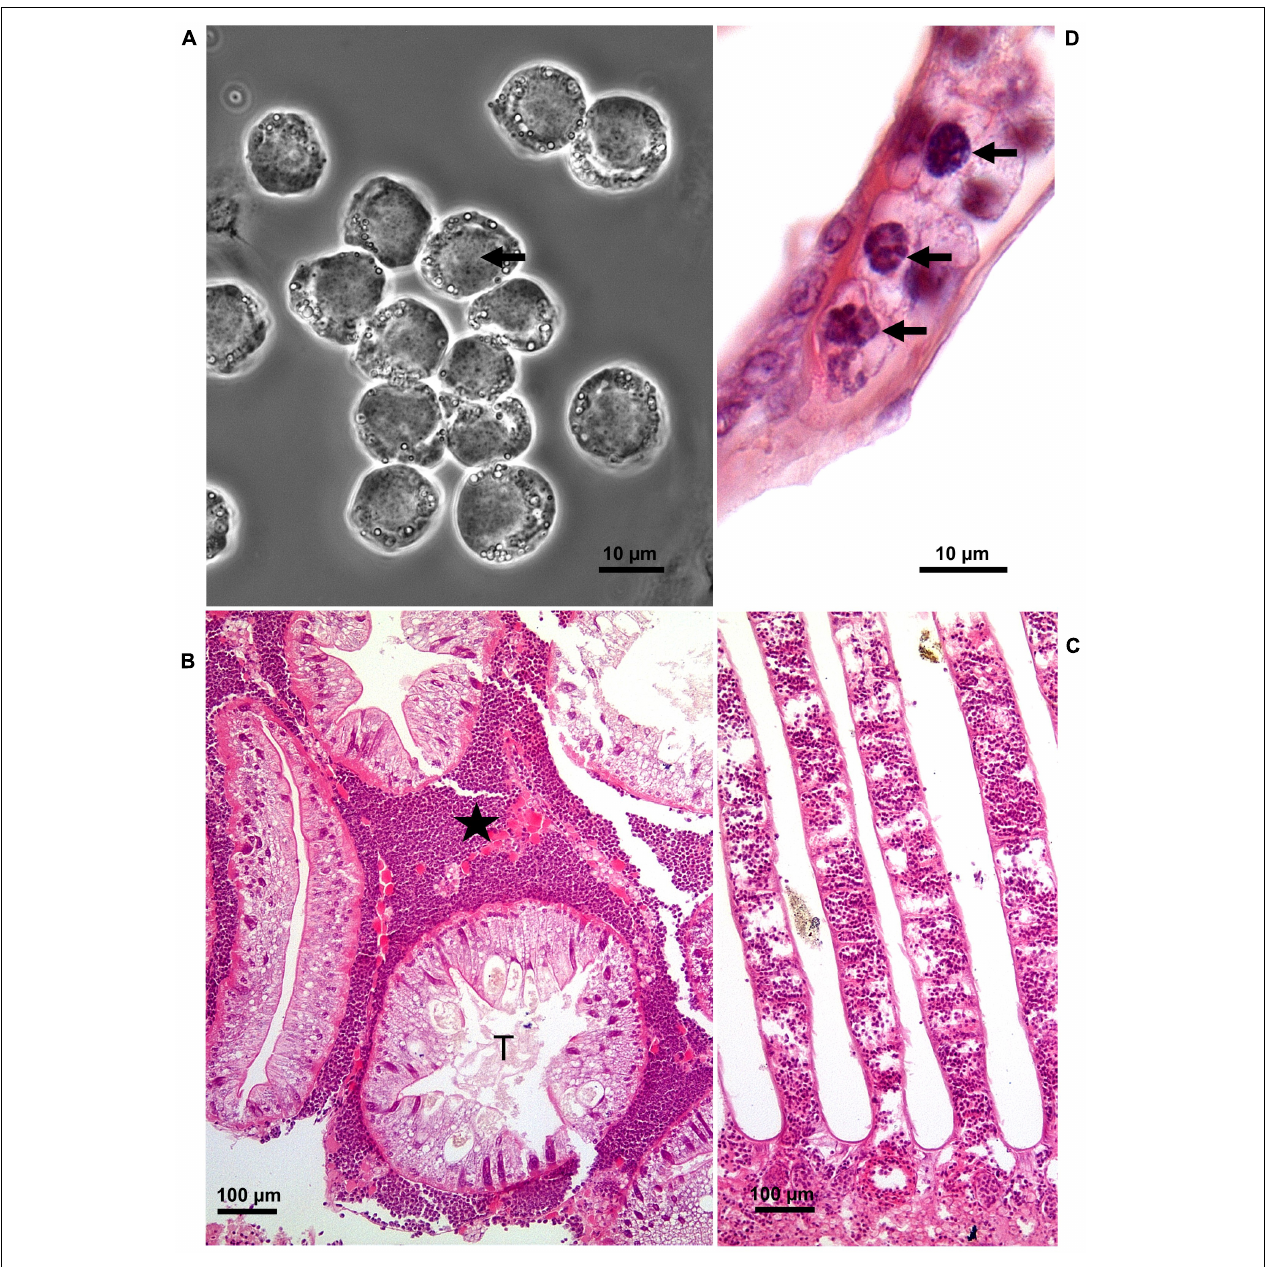
FIGURE 1 | Hematodinium infection of shore crab, Carcinus maenas . (A) Phase contrast micrograph of haemolymph replete with trophont stages of Hematodinium sp. The nuclei contain chromatin with a granular appearance (arrow) and the cytoplasm has many phase-bright droplets. (B) Histological section of hepatopancreas from a crab with a high severity infection. The interstitial spaces between the tubules (T) are swollen and replete with Hematodinium parasites (*). (C) Section through the gill region of a heavily infected crab with numerous Hematodinium parasites in the lumen of swollen gill filaments. (D) High power micrograph of a histological section of gills showing the appearance of Hematodinium parasites with highly characteristic chromatin (arrows). Panels (B–D) are histological sections stained with haematoxylin and